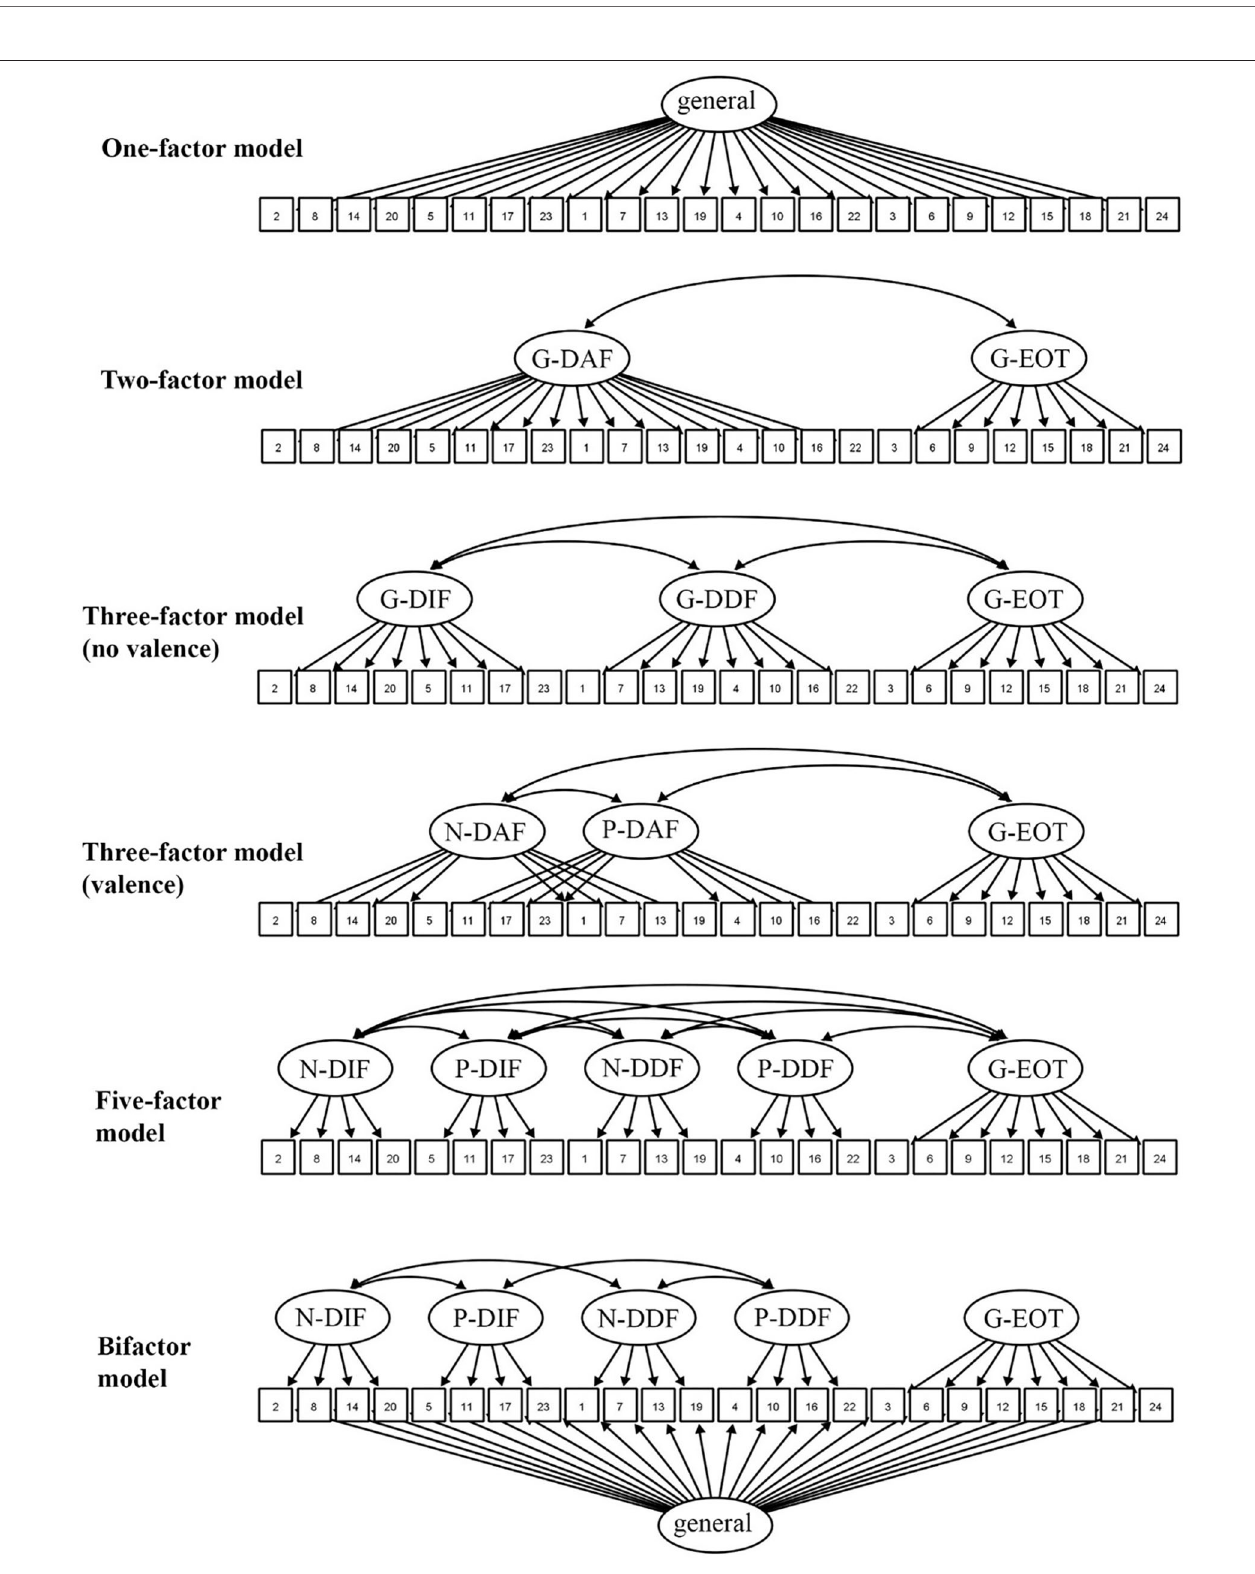
FIGURE 1 | The examined confirmatory factor analysis models for the Perth Alexithymia Questionnaire. Ellipses = latent factors, squares = item numbers. Each item had an associated error term.